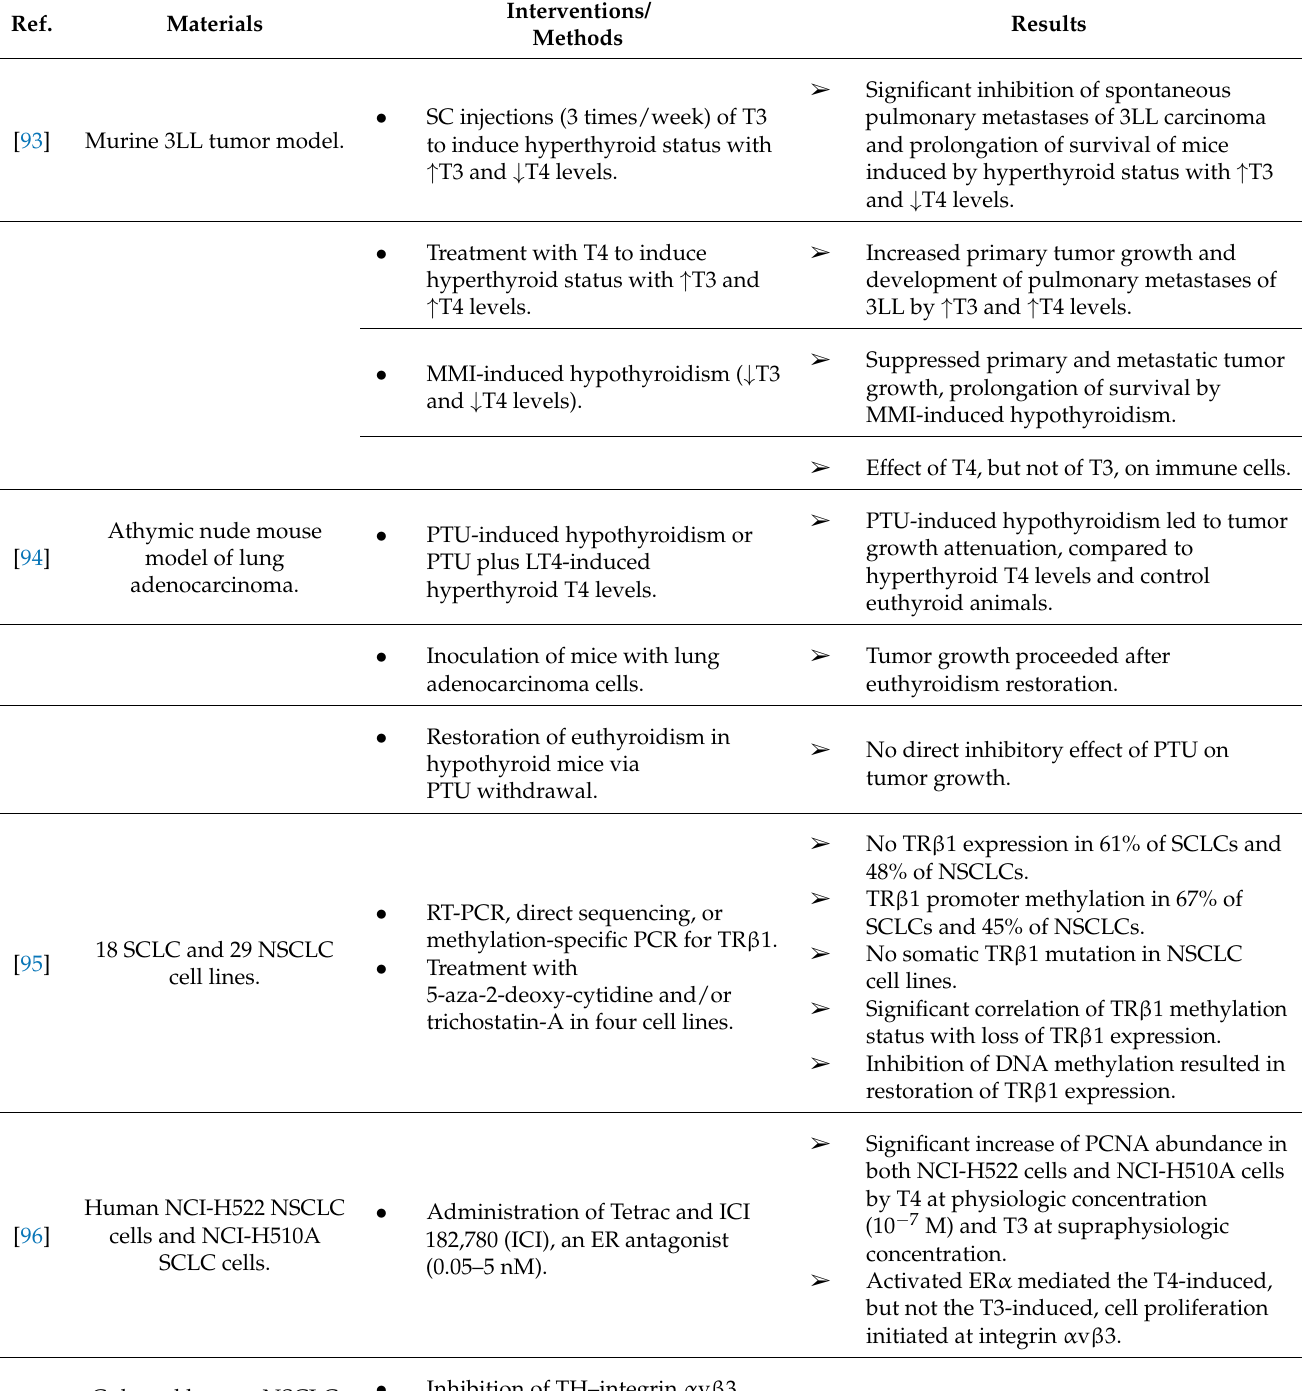
Table 2. Nonclinical studies addressing the TH-lung cancer